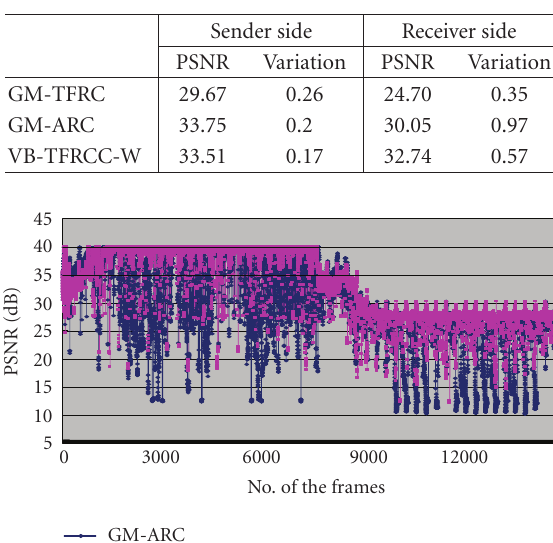
Table 1: PSNR of GM-TFRC, GM-ARC, and VB-TFRCC-W.